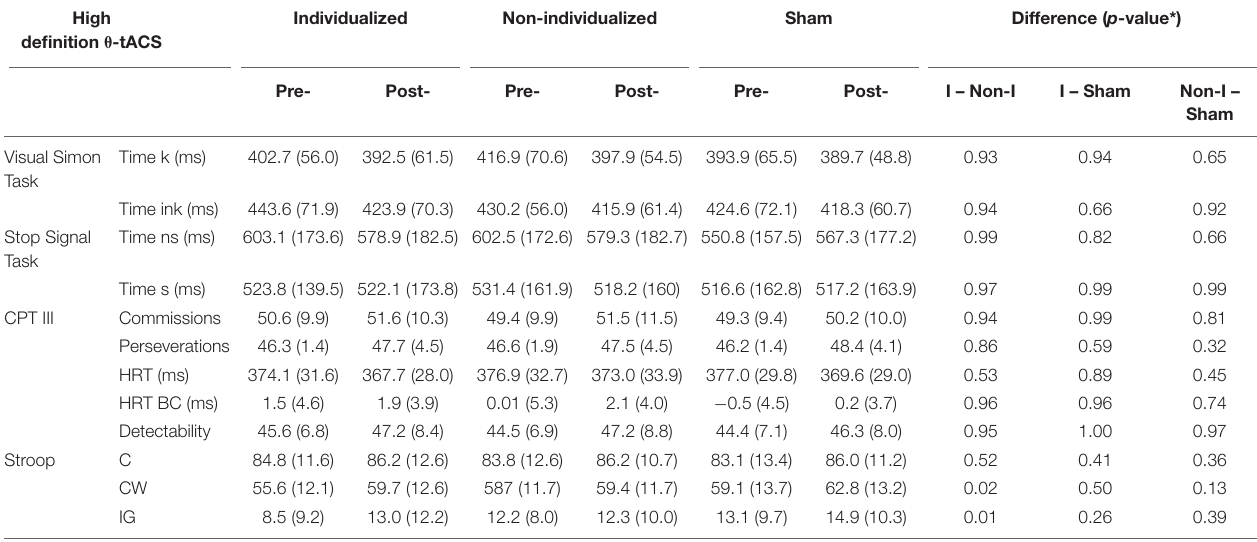
TABLE 2 | Post-modulatory effect of High Definition θ -tACS on cognitive performance. High Individualized Non-individualized definition θ -tACS